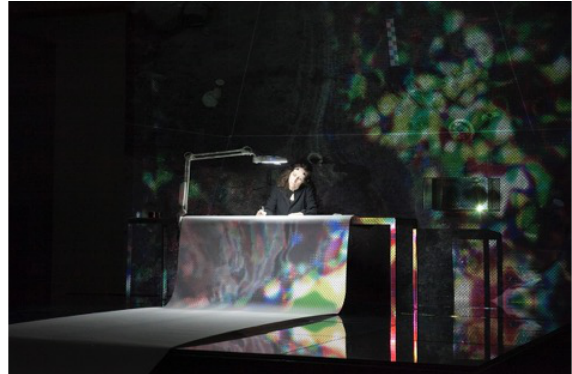
Figure 2 | Enhancing the Mind’s I . Detail of a performance setting. Source: the author,